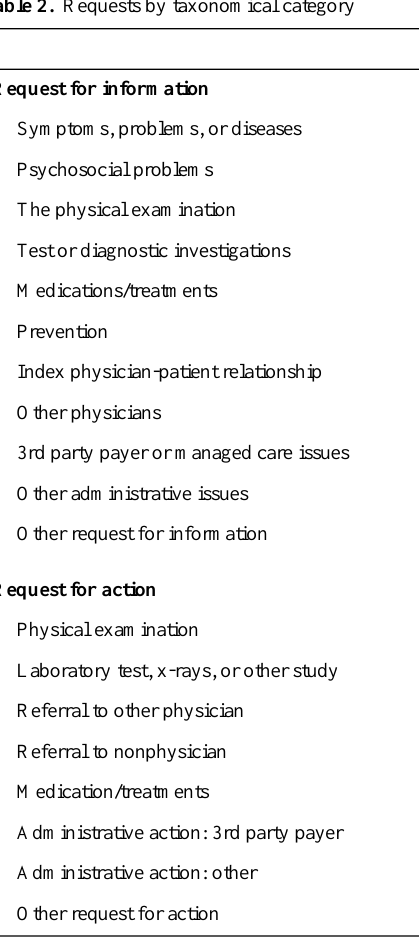
Table 2. Requests by taxonomical